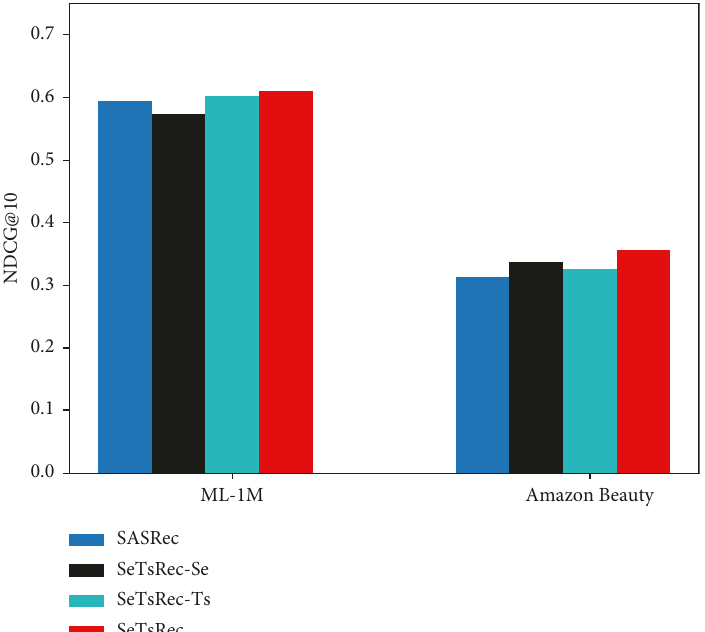
Figure 11: Results of ablation experiment on NDCG@10.